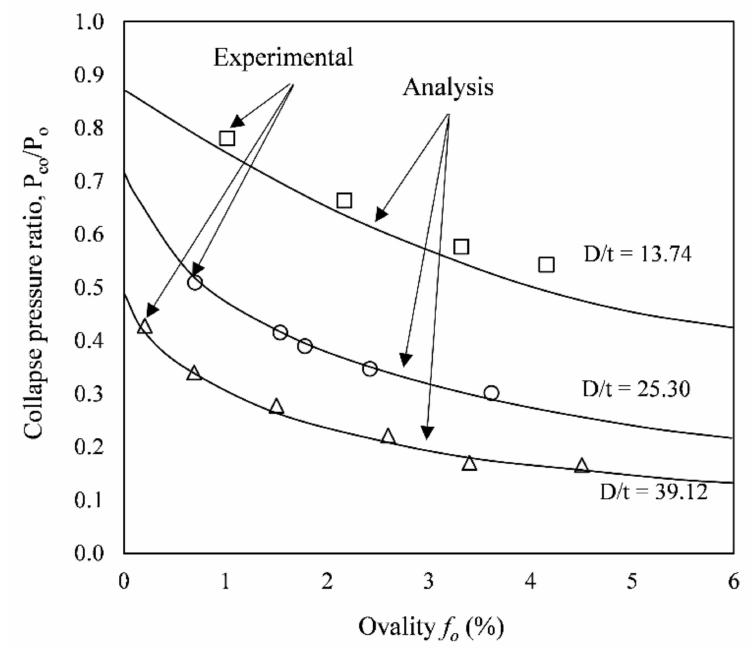
Figure 17. Influence of diameter-to-thickness ratio and initial ovality of the pipeline on the collapse pressure of pipeline under external pressure